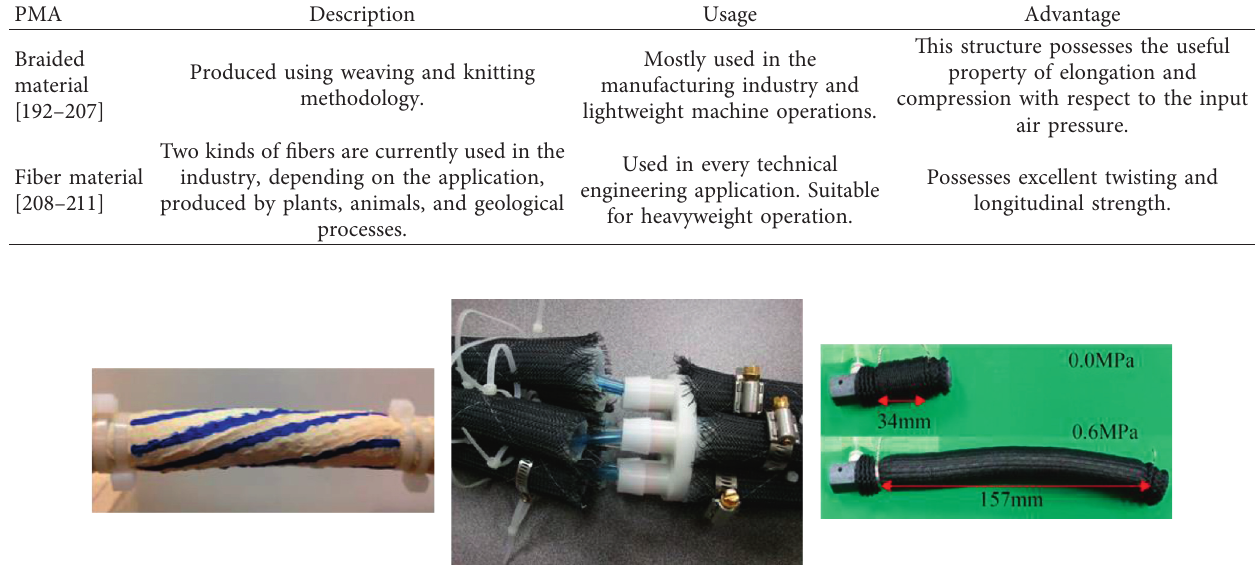
Figure 8: Pneumatic artificial muscle—fiber material and braided structure [206–209]. Table 7: Electric motors as force actuators.